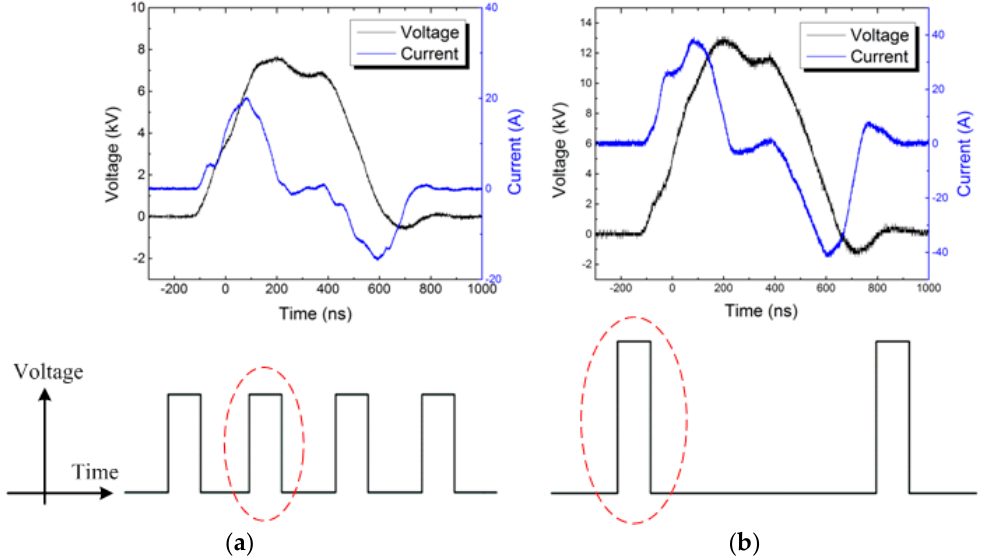
Figure 7. Voltage-current waveforms of NS-DBD with two different discharge conditions: ( a ) LV-HF discharge; ( b ) HV-LF discharge.